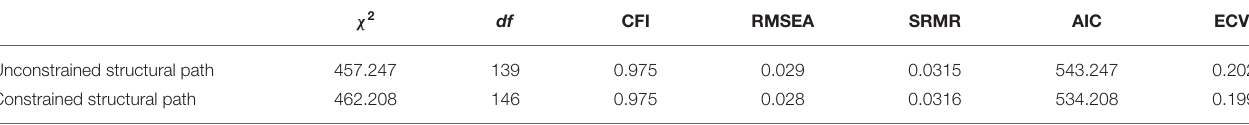
TABLE 4 | Comparison of constrained and unconstrained structural path models for transgender. χ 2 df CFI RMSEA